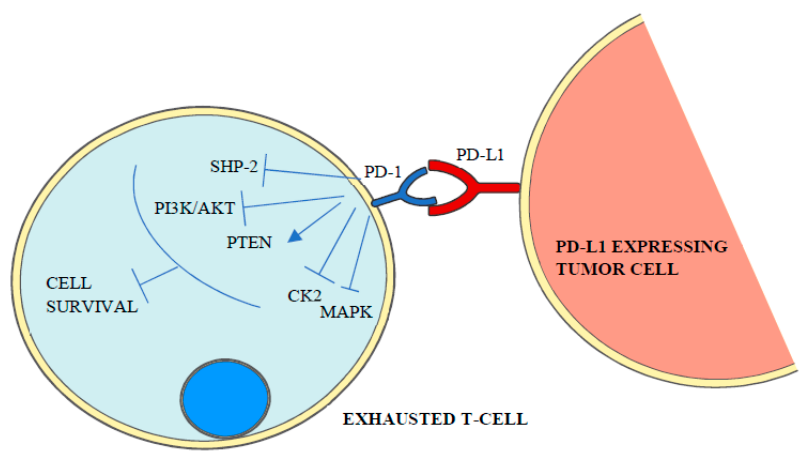
Figure 2. PD-1 binding to its ligand triggers the activation of intracellular signaling cascades that mediate the dephosphorylation and inactivation of T-cell receptor proximal signal components such as SHP-2, PI3K / AKT, MAPK and CK2 leading to lymphocyte exhaustion.